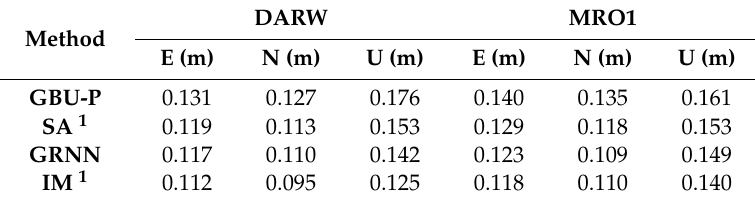
Table 6. The standard deviation (STD) values of DARW and MRO1 station in North (N), East (E), and Up (U) directions of the kinematic PPP solutions (after the initialization phase, with 5 min sample interval).